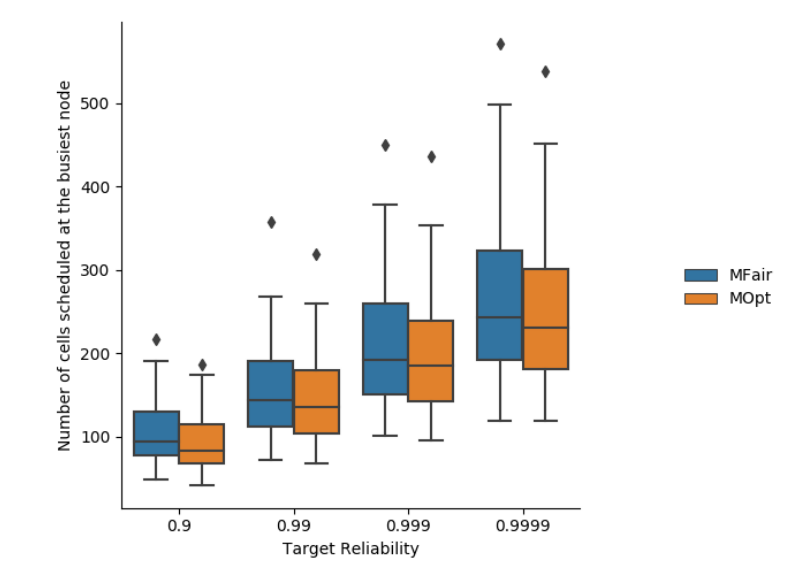
Figure 13. Number of cells assigned by MFair and MOpt on the busiest node.